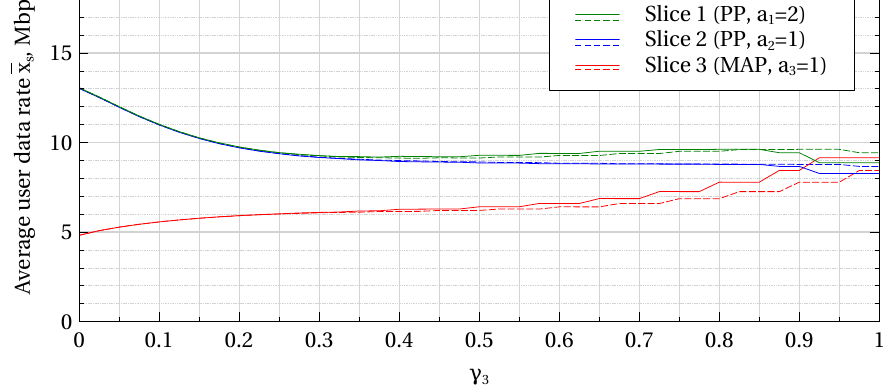
Figure 5. The average data rates ¯ x s vs. γ 3 ; γ 2 = α − γ 3 lines— α = 1.1).